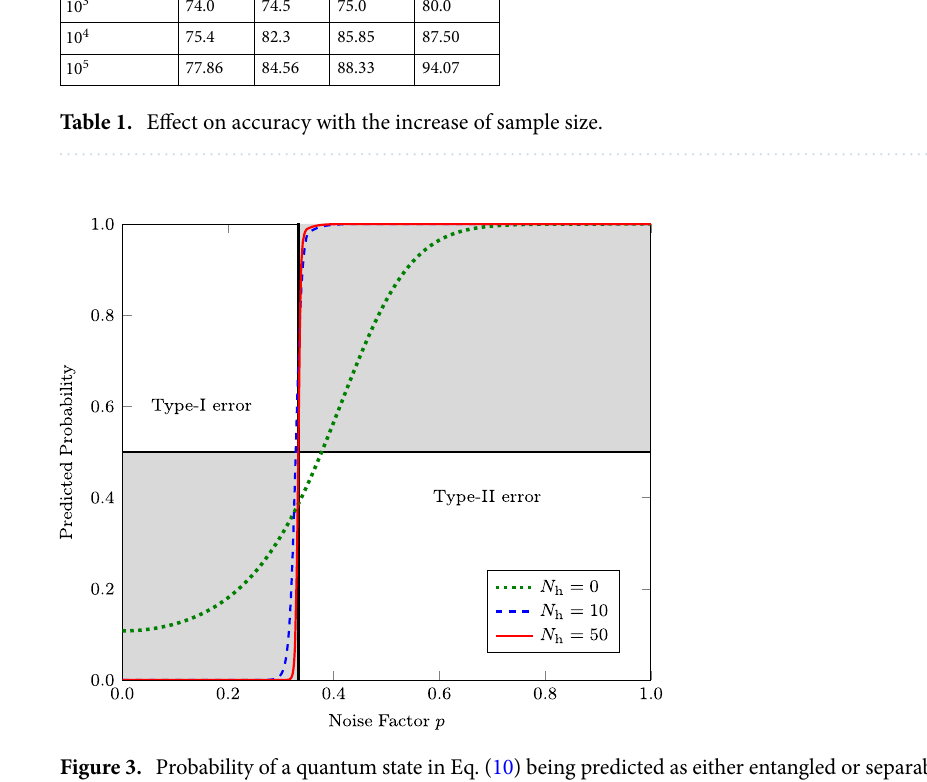
Figure 3. Probability of a quantum state in Eq. (10) being predicted as either entangled or separable as a function of the noise factor p . Here N h denotes the number of neurons in the hidden layer. Truly entangled and truly separable regions are represented by shaded regions. This also highlights the effect on detection accuracy with the increase in the number of hidden-layer